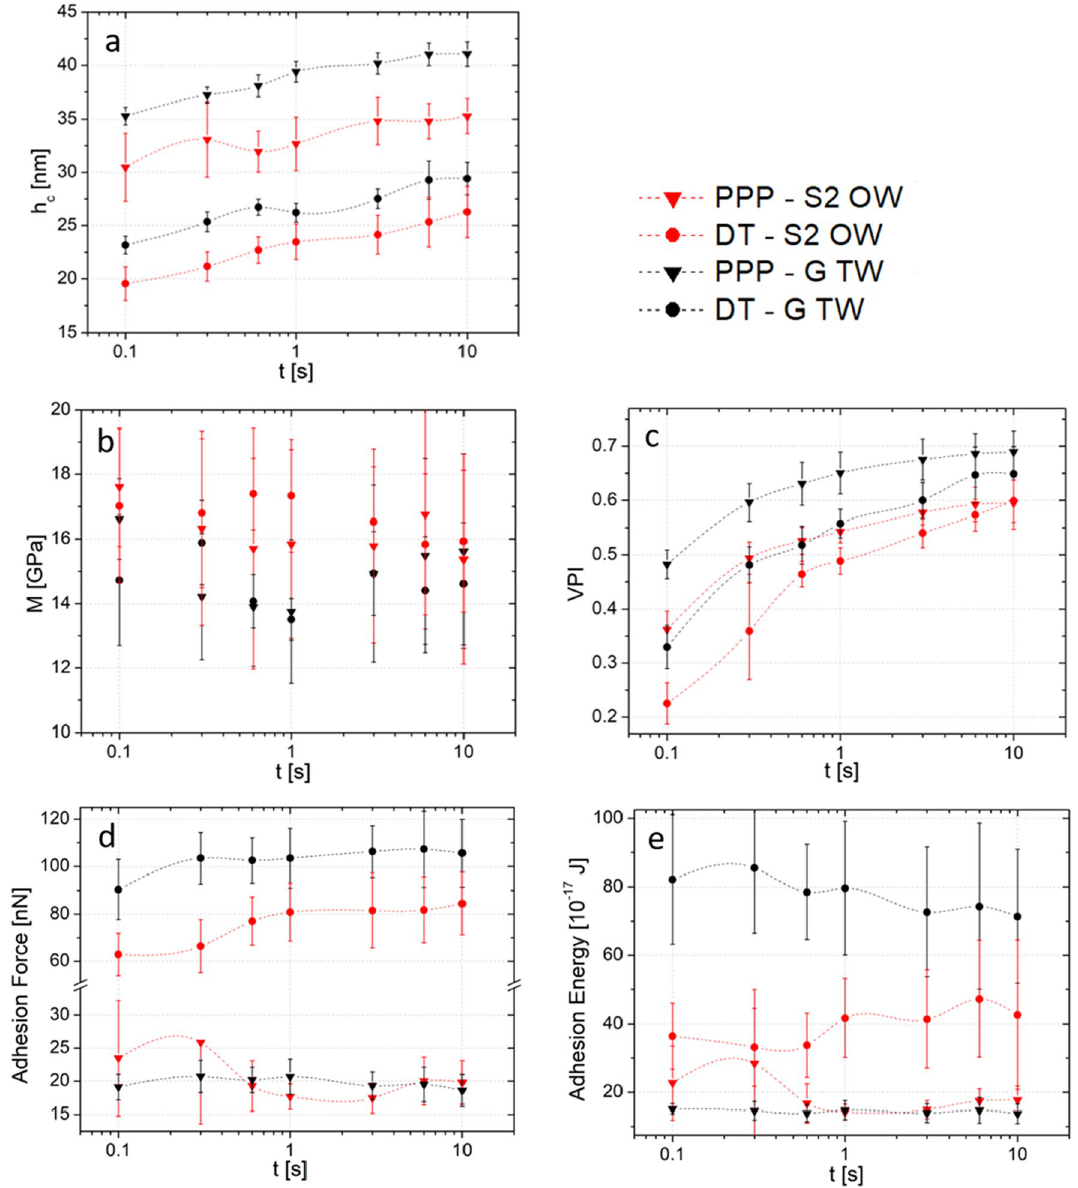
Figure 4. Influence of indentation time on: ( a ) indentation depth, ( b ) indentation modulus, ( c ) viscoplasticity index, ( d ) adhesion force, ( e ) adhesion energy. Measurements are made with DT probe (circles) or PPP probe (triangles) on S2 layer of opposite wood (OW, red) or G layer of tension wood (TW, black). The dash-dotted lines are guides for the eye. Error bars are standard deviation, n =